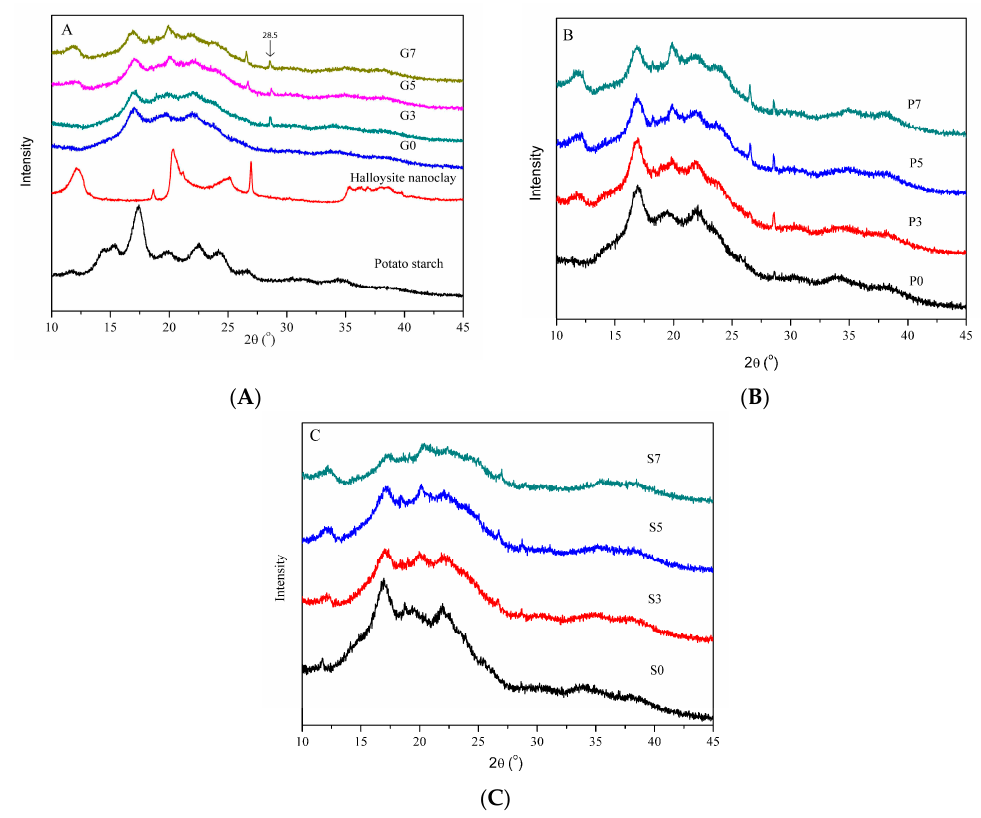
Figure 3. XRD patterns of the raw materials and the different nano-biocomposites with various nanofiller contents. From top to bottom, ( A ) native potato starch alone, halloysite nanoclay alone, A ) native potato starch alone, halloysite nanoclay and nano-biocomposites based on glycerol-plasticized starch; ( B ) nano-biocomposites based on nanofiller contents. From top to bottom, (